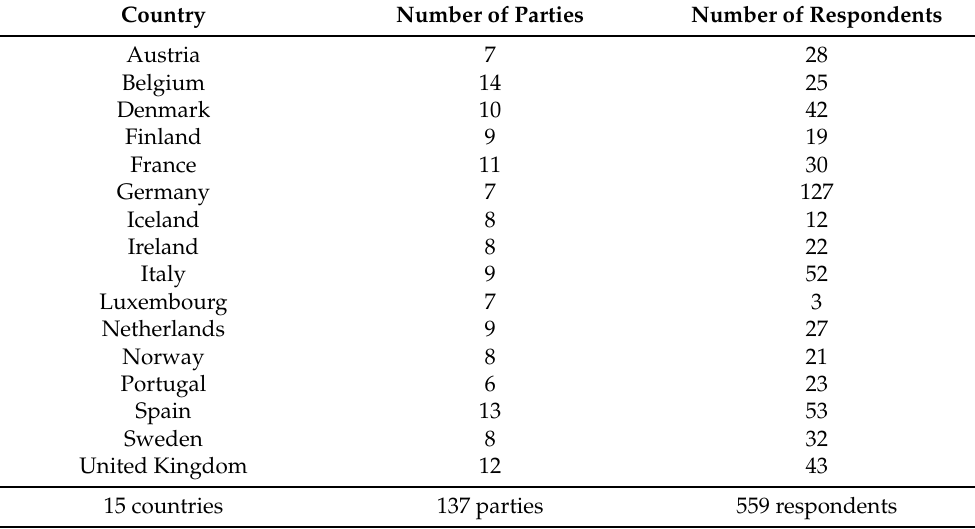
Table 1. The Policy vs. Office Goals